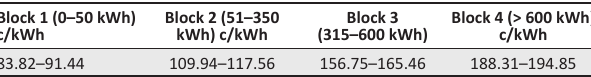
TABLE 3: Domestic inclining block tariff benchmarks.